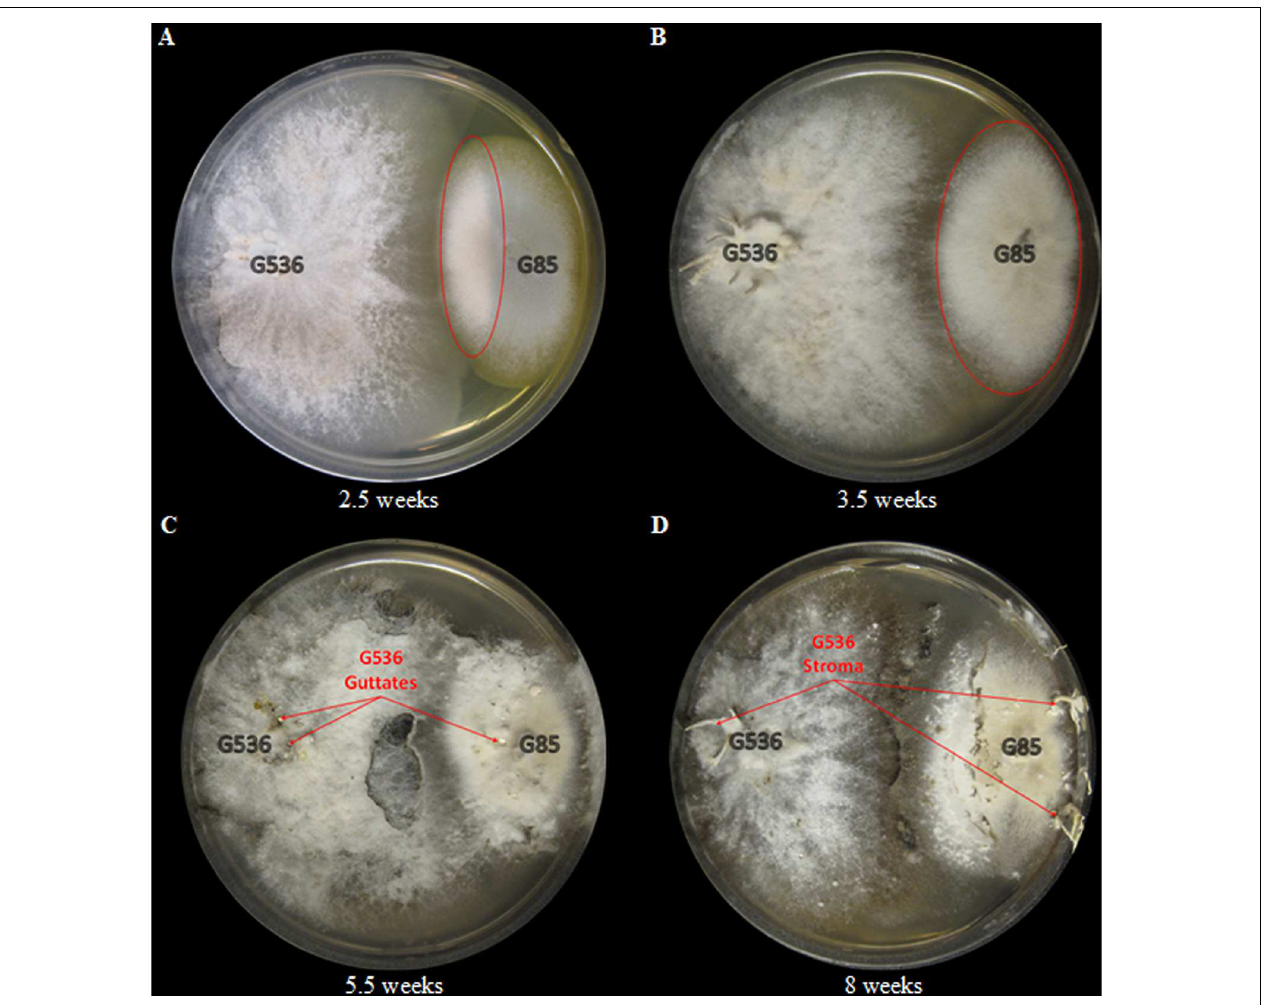
FIGURE 9 | The visible discoloration of P. restrictum (G85) while in co-culture with the griseofulvin-producer, X. cubensis (G536), at (A) 2.5 weeks and (B) 3.5 weeks. The discolored regions of P. restrictum (G85) are circled in red. The visible expansion of X. cubensis (G536) while in co-culture with P. restrictum (G85) at (C) 5.5 weeks and (D) 8 weeks. The guttates were attributed to X. cubensis (G536) due to the detection of griseofulvin. The stroma were attributed to X. cubensis (G536) since P. restrictum (G85) does not produce stroma.